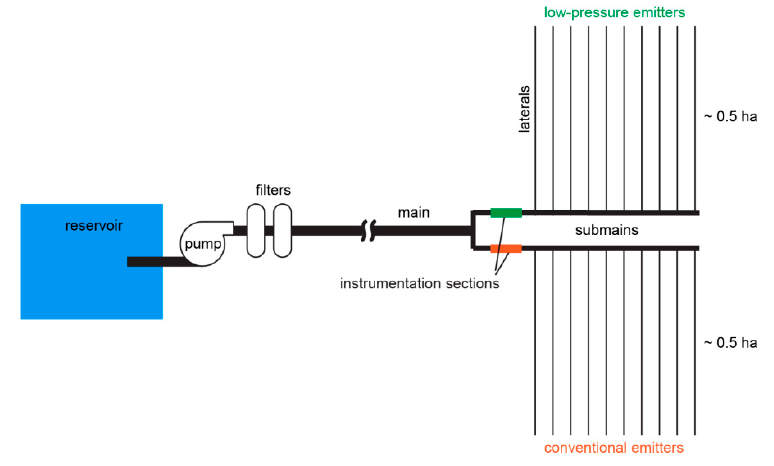
Figure A1. General site diagram, highlighting one control-test pair of plots. Water was delivered to both plots by the same pump, via a main pipe that branched into multiple submain pipes. The instrumentation sections on the submains contained a valve to regulate pressure, and flow and pressure sensors to monitor the water flow.